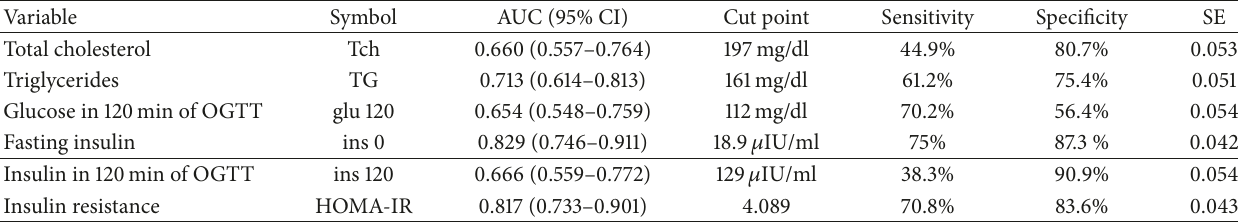
Table 4: Diagnostic value of analysed variables in NAFLD prediction.